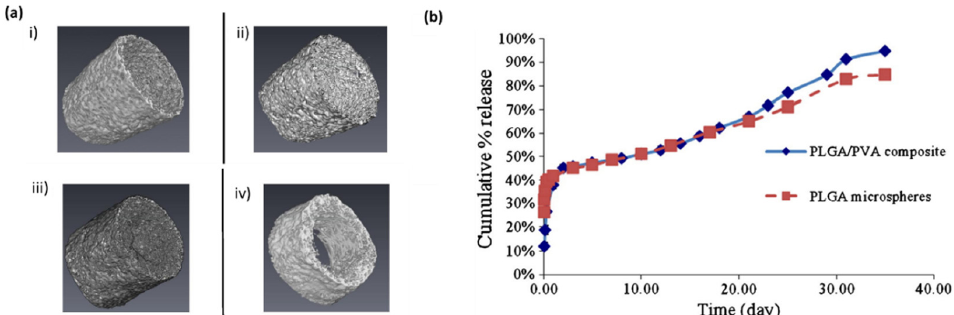
Figure 3. Strategies for reducing foreign body response (FBR) in implantable biosensors. ( a ) Dexamethasone-releasing polyurethane coatings for glucose sensors. Micro-CT images of porous coatings created via the salt-leaching/gas-foaming technique with decreasing porogen fraction. The porogen concentration. (i) (ii) 90%, (iii) 60% and (iv) 30% [79]. ( b ) In vitro release profiles of poly(lactic- co-glycolic) acid (PLGA) microspheres and PLGA microsphere/PVA hydrogel composite coatings ( n